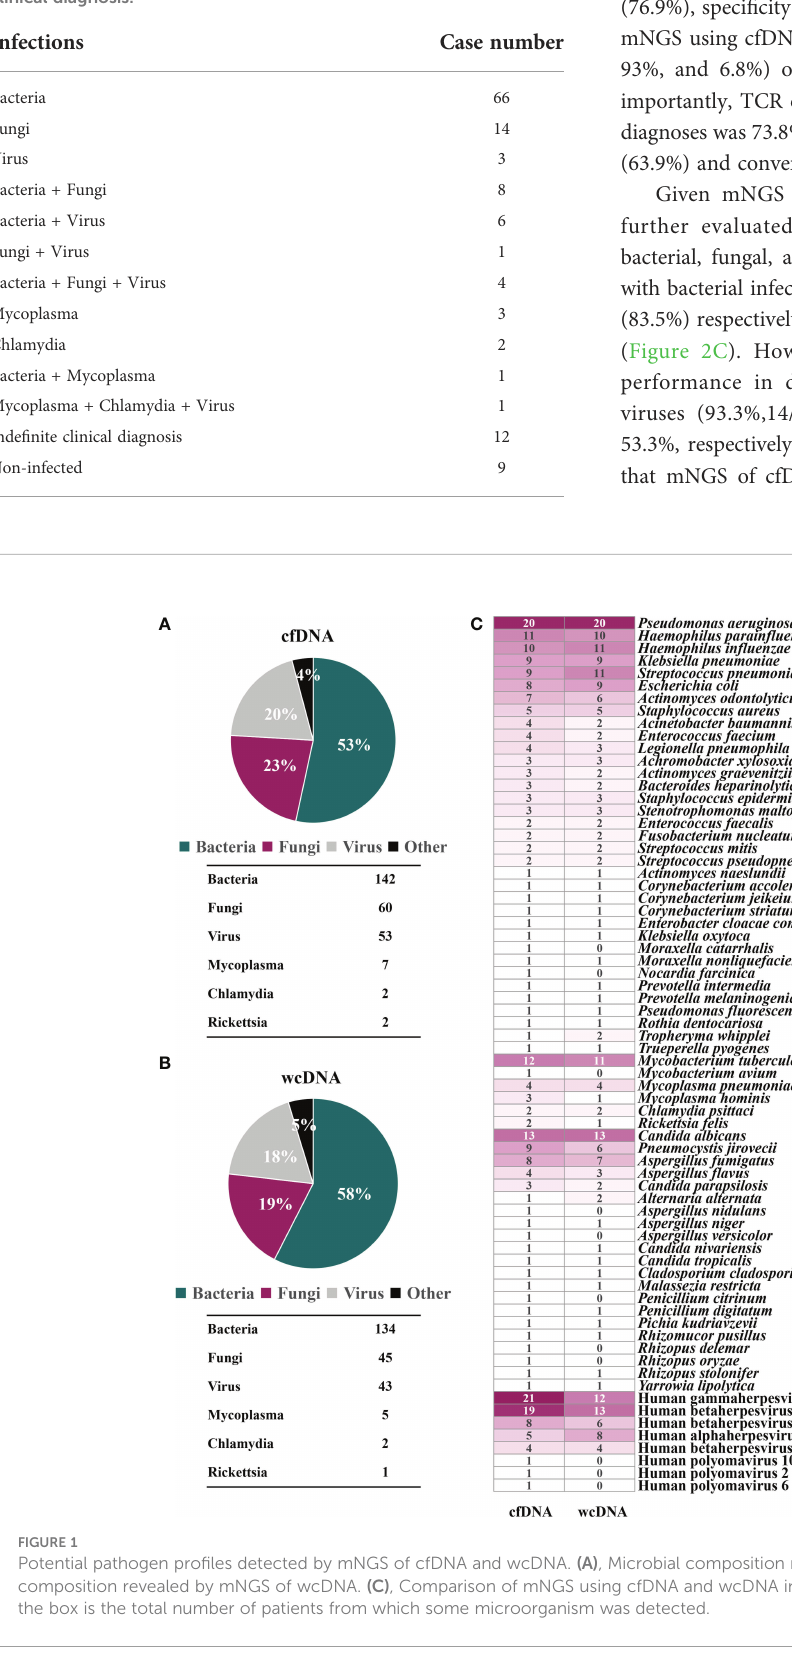
TABLE 2 The types of infections of enrolled patients based on clinical